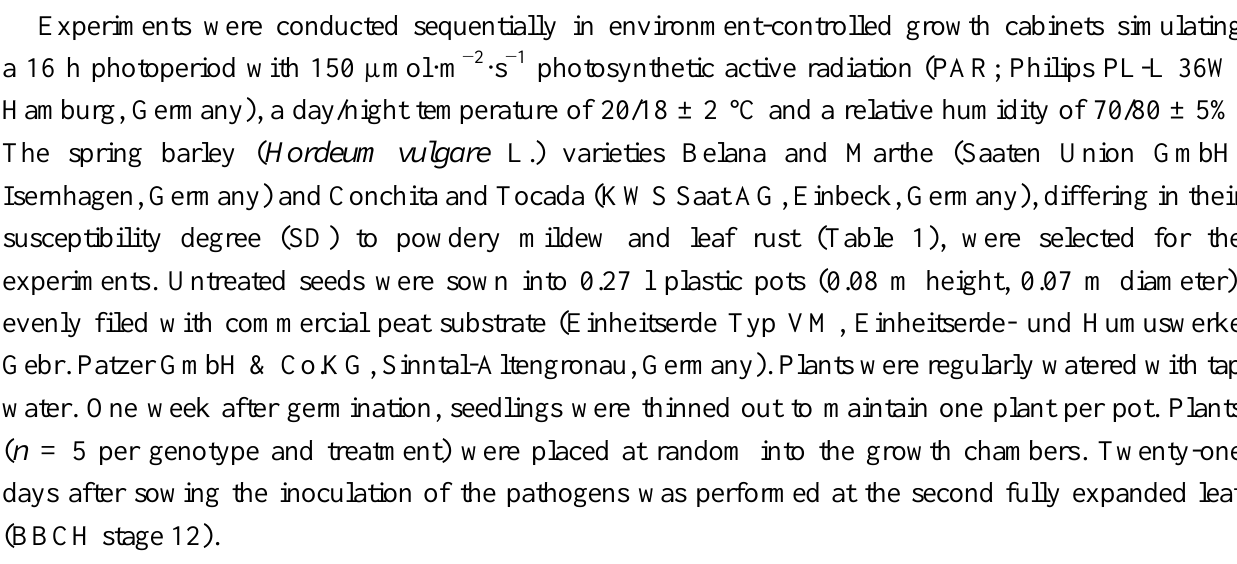
Table 1. Susceptibility degree of the selected varieties to powdery mildew and leaf